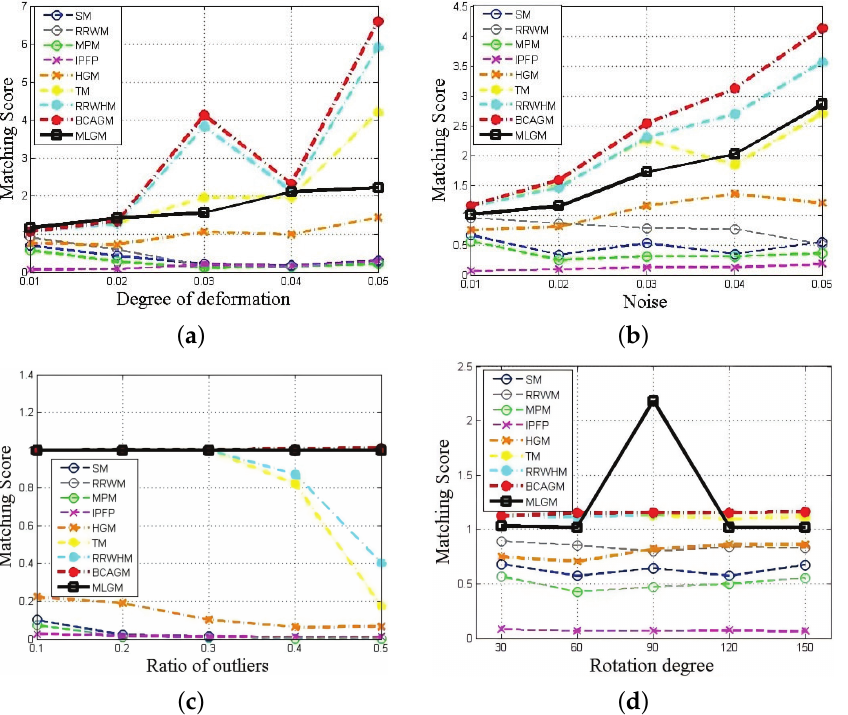
Figure 8. Matching score comparison on the Fish dataset. ( a ) Matching score with different degree of deformation. ( b ) Matching score with different noise level. ( c ) Matching score with different number of outliers. ( d ) Matching score with different rotation angle.